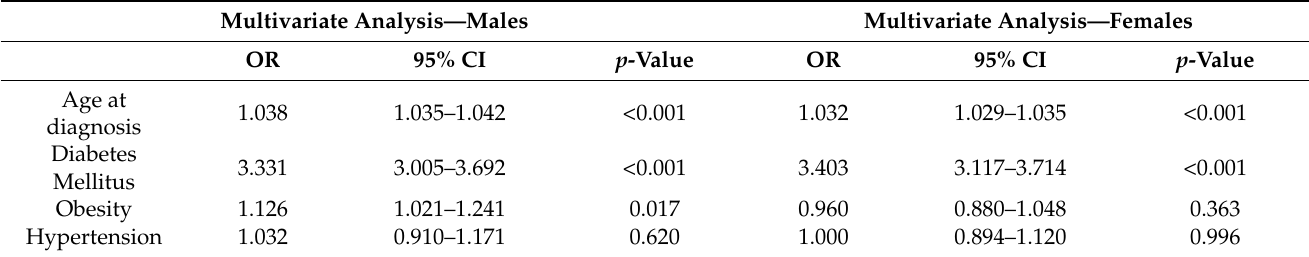
Table 6. Univariate and multivariate analyses of risk factors for cirrhosis among NAFLD patients. Multivariate Analysis—Males Multivariate Analysis—Females